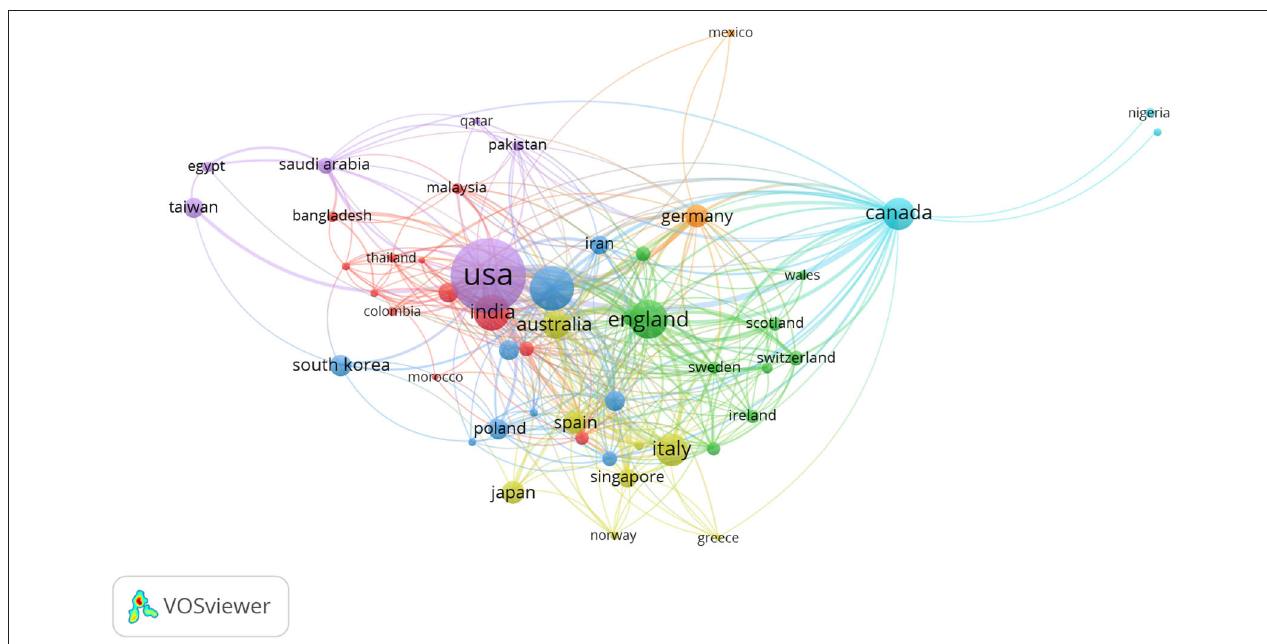
FIGURE 1 | Network visualization map of co-authorship country. A minimum of five documents per country was fixed. Of the 94 countries, only 55 meet the threshold. The size of the circle represents the number of articles published by the country, and the larger the circle, the higher the country’s contribution to co-authorship. The more connections between the two countries, the stronger cooperation exists between the two